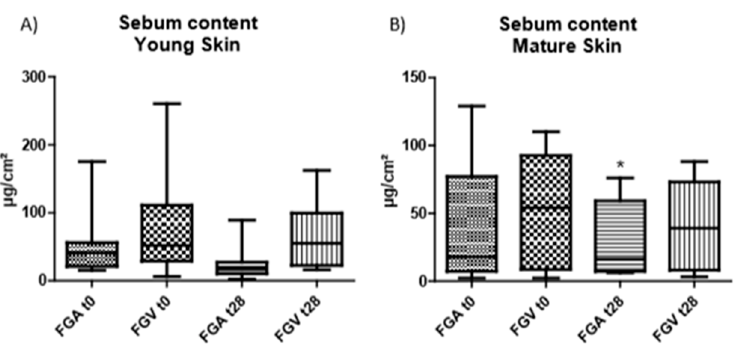
Figure 3. Sebum content of the skin before (t0), and after 28 days (t28) of application of the formu- lations FGA (gel cream containing 0.1% of Spirulina extract) and FGV (gel cream without Spirulina extract) on young skin (18–39 years) ( A ) and mature skin (40–65 years) ( B ) (* Kruskal–Wallis, p < 0.05). Published by ref. [30].